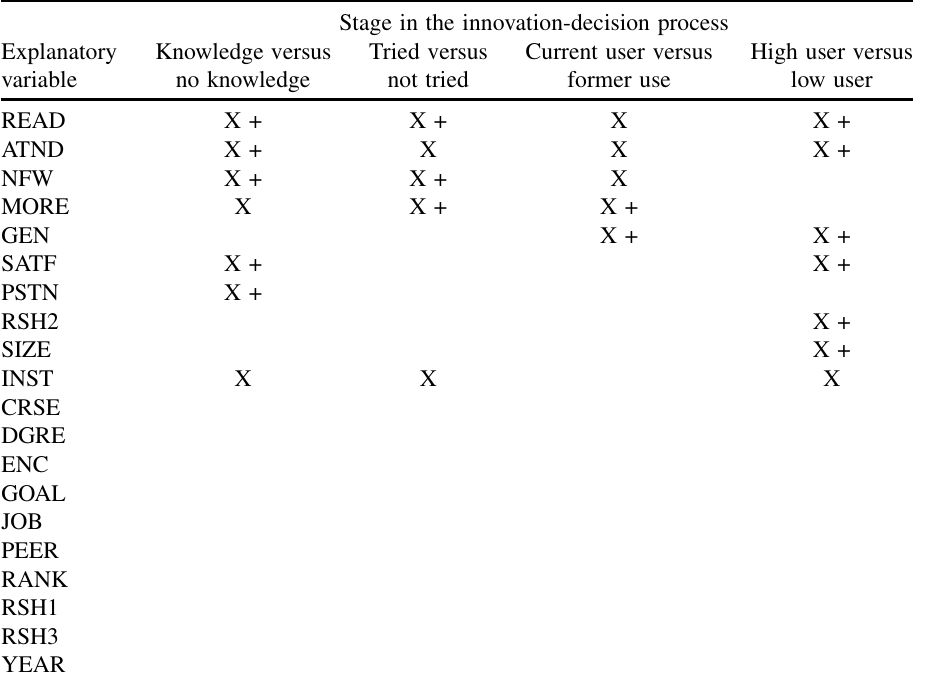
TABLE IV. Significant explanatory variables at each stage in the innovation-decision process. An ‘‘X’’ indicates that the variable is significant at p ¼ 0 : 05 on a Pearson’s chi-square test or one-way analysis of variance (ANOVA) without controlling for other correlates. A ‘‘+’’ indicates that the variable continues to be significant in a logistic regression model that controls for all 10 variables that were significant individually. Variables are ranked in terms of the number of stages for which they are